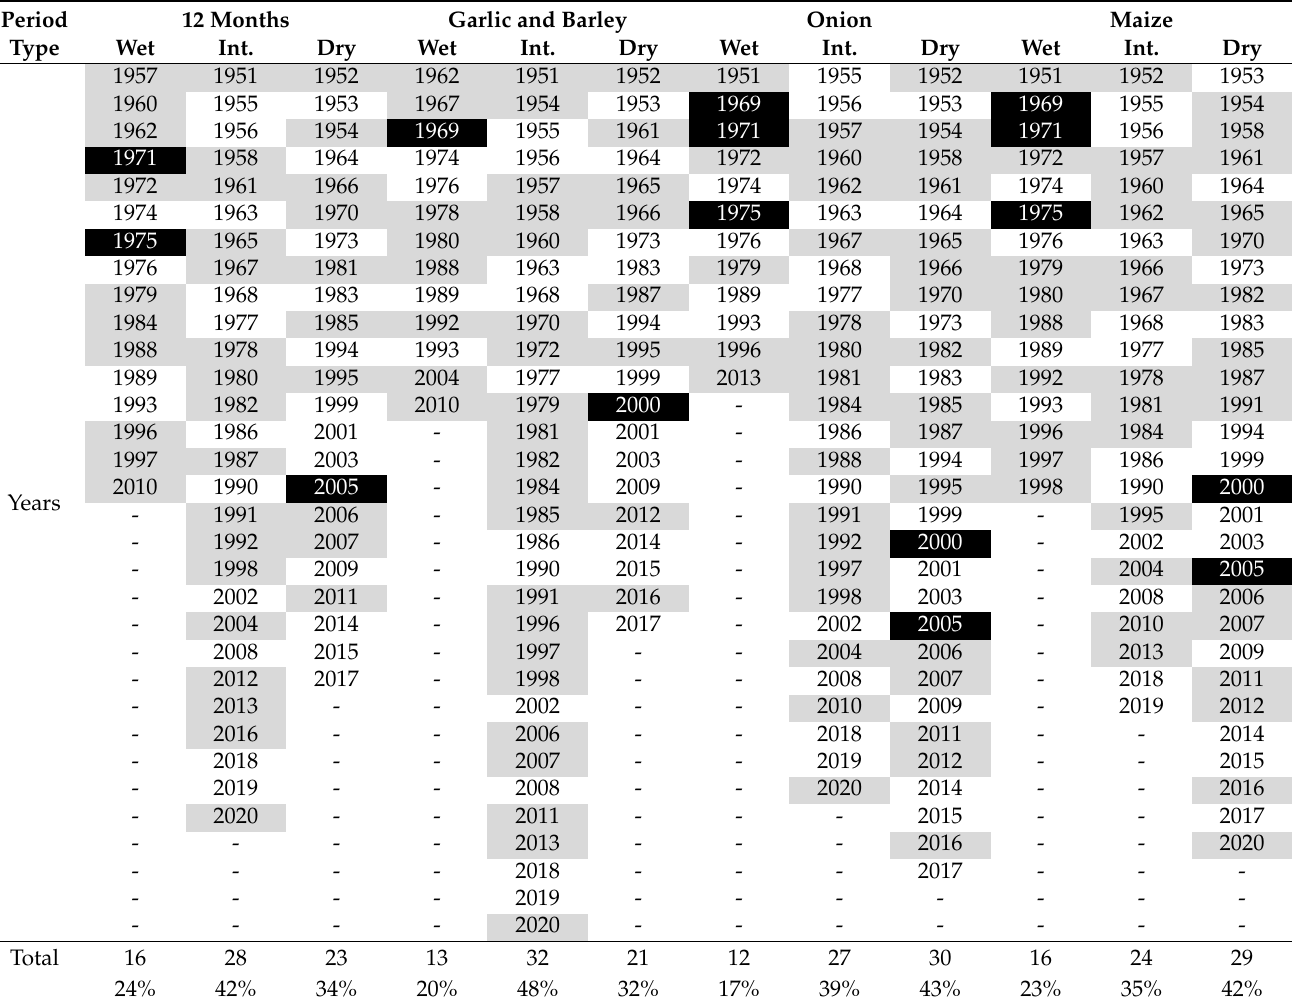
Table 2. Classification of years (wet, intermediate “Int.”, or dry) for different growing periods. Period Garlic and Barley Onion